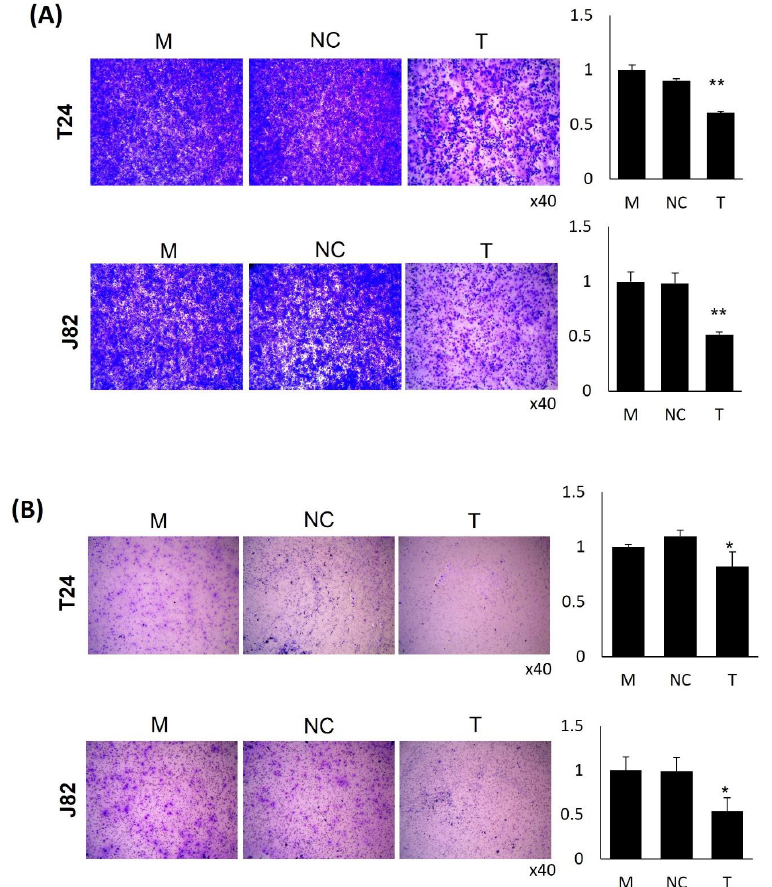
Figure 2. Migration and invasion assay of PDK4 knockdown bladder cancer cells. ( A ) Migration assay. ( B ) Invasion assay. All data represent means ± SD of three independent experiments (* p < 0.05, ** p < 0.01 NC vs. T). M: mock, N: negative control, T: PDK4 siRNA treated.